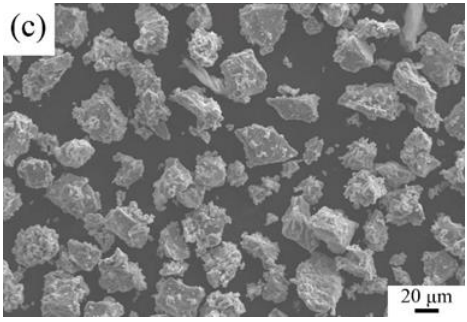
Figure 1. SEM images of raw materials: ( a ) GF; ( b ) Cu powders; ( c ) Ti powders.